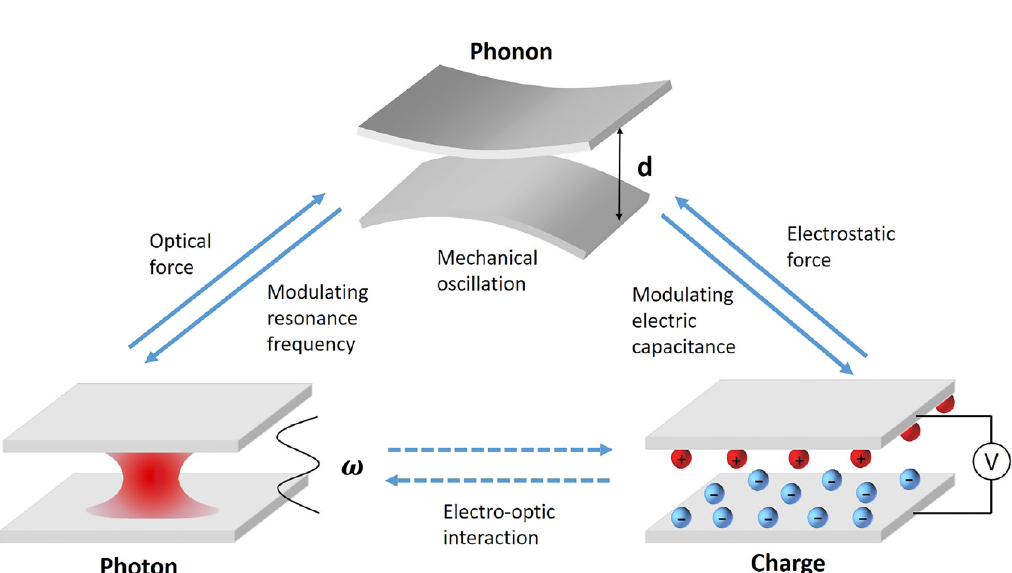
be regarded as a resonator affected by mechanical